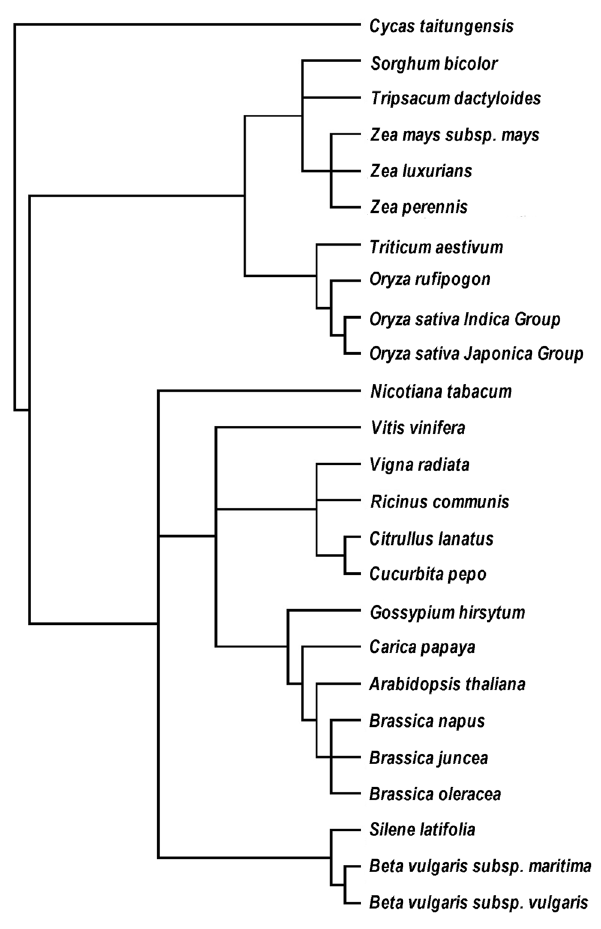
Figure 8. NCBI common tree of 25 analyzed species.